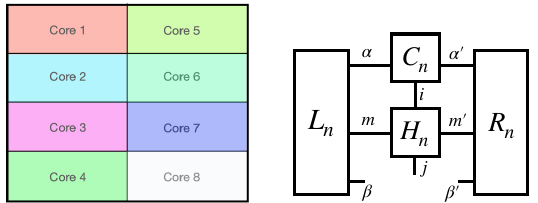
FIG. 1. Left: matrix distribution pattern on TPU cores. The figure shows the distribution pattern of a D × D matrix on eight available TPU cores, arranged on a 4 × 2 torus. Each colored panel has shape D / 4 × D / 2. Right: tensor network diagram for a key tensor contraction in the DMRG algorithm, where the one-site MPS tensor (regarded as an effective vector wave function for a given site) is multiplied by three other tensors (corresponding to an effective Hamiltonian for that